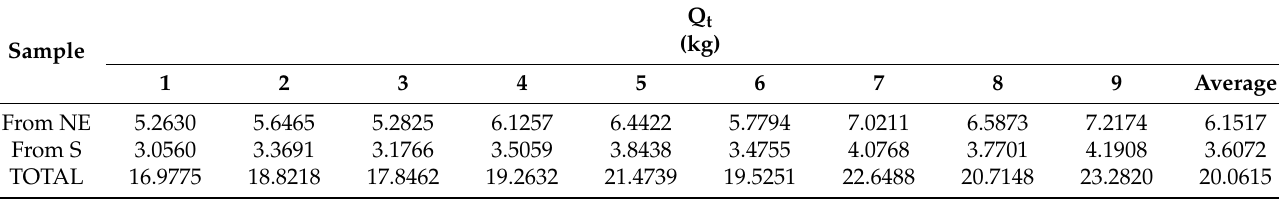
Table 3. Total mass transport (Q t